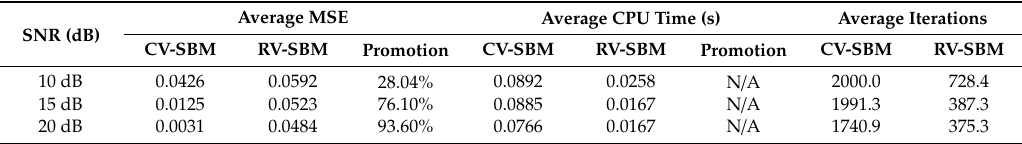
Table 2. Comparison of CV-SBM and RV-SBM when tol = 2e − 4 , k max = 2000, and n = 256.